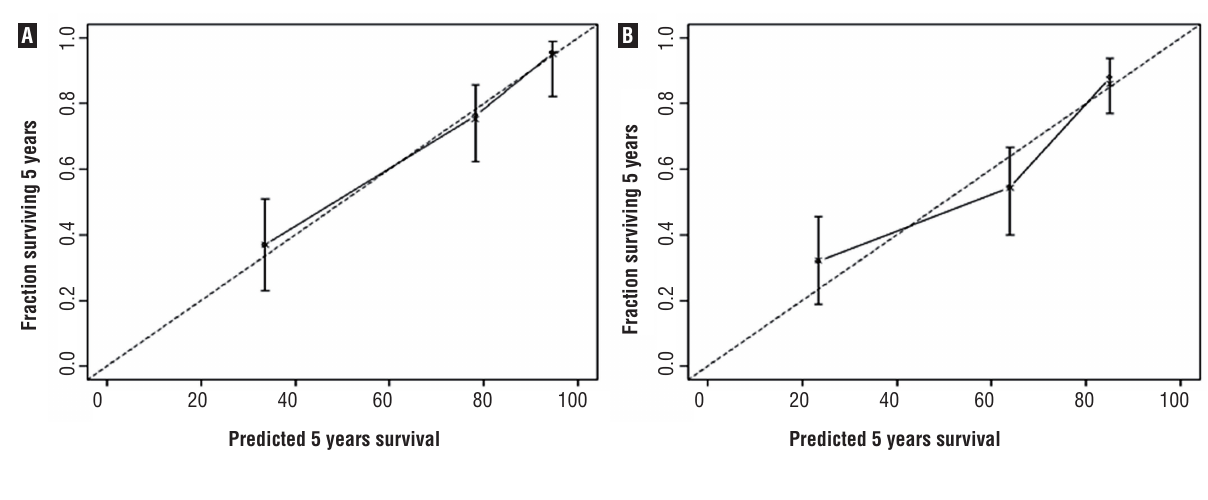
Figure 3 - (A) Calibration curves for 5-year disease-specific survival predictions. (B)